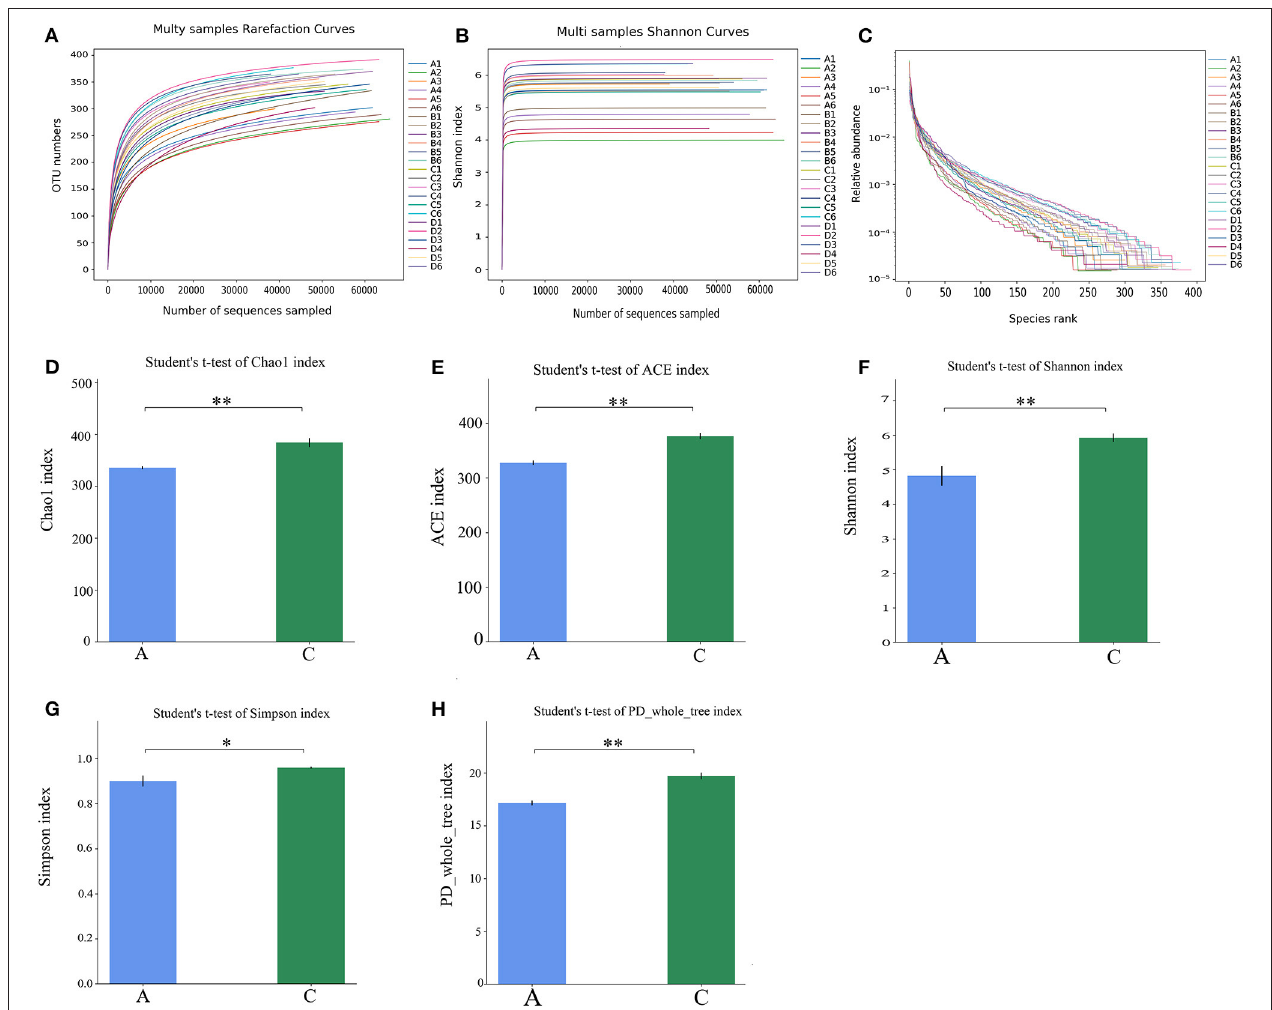
FIGURE 2 | Mouse fecal sample dilution curve (A) , Shannon index (B) , Rank-Abundance curve (C) and histogram of difference between NT-free group and NT intervention group in Alpha diversity index (D–H) . (A) : NT-free group; (B) : basal diet group; (C) : NT intervention group; (D) : model control group. *p < 0.05, **p <